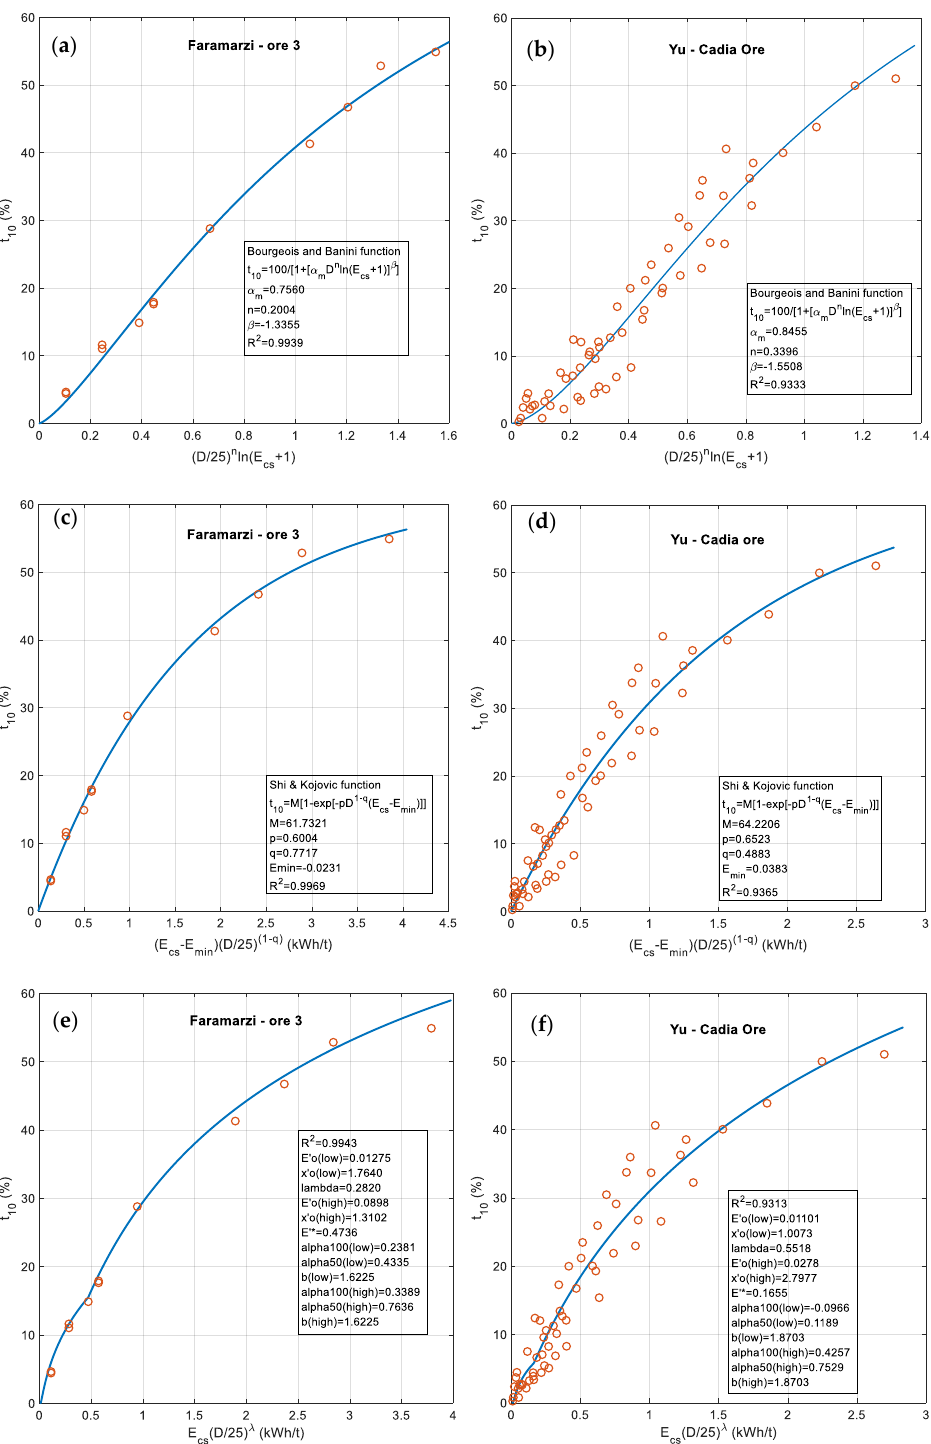
Figure A8. Breakage index plots for Faramarzi’s ore 3 ( a , c , e ) and Yu’s Cadia ore ( b , d , f ). ( a , b ): Banini’s BIE, ( c , d ): JK new BIE and ( e , f ): double fan BIE. For both ores, the higher determination is the JK (with 𝐸 𝑚𝑖𝑛 < 0 in ore 3, 𝑅 2 = 0.9969, and 𝐸 𝑚𝑖𝑛 > 0 in Cadia ore, 𝑅 2 = 0.9365.